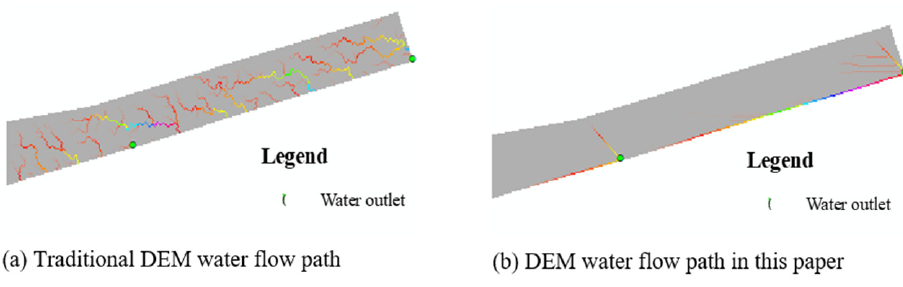
Figure 11. Comparison of water flow routes extracted by different DEMs.